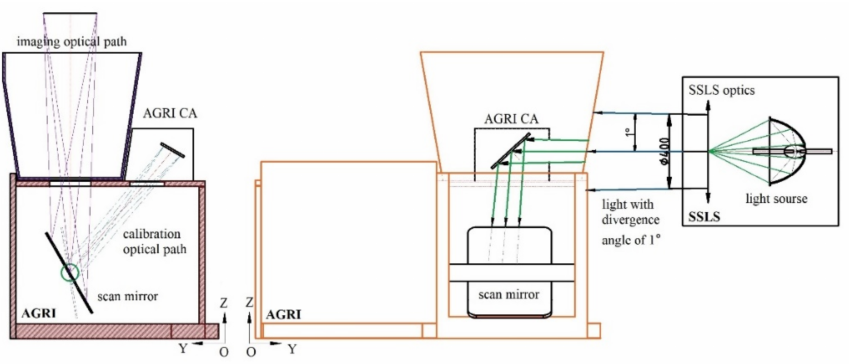
Figure 6. Calibration optical path and imaging optical path of the